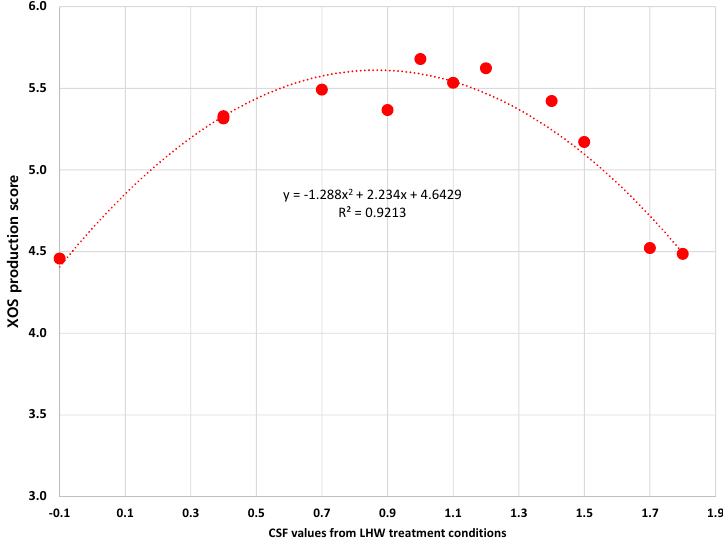
Figure 5. The relationship between XOS production score and CSF values.